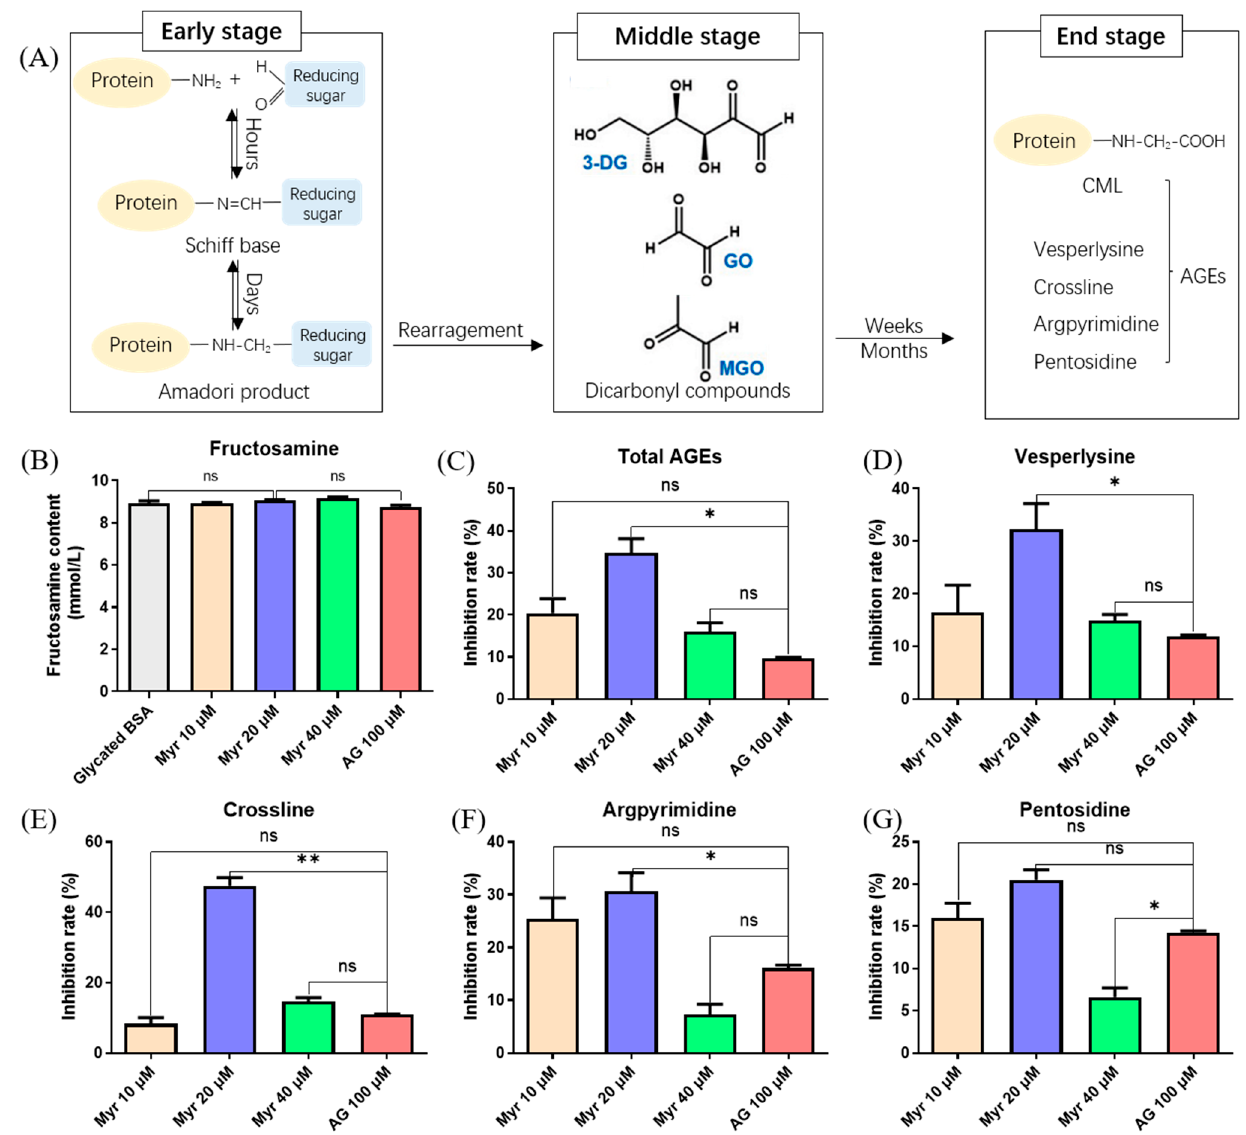
Figure 1. Effects of Myr on the glycation products formed in BSA-Glucose model at different stages. ( A ) Diagram of formation process of advanced glycation end products (AGEs). ( B ) Content of fructosamine generated at the early stage in BSA-glucose system incubated with Myriocin (Myr) or aminoguanidine (AG), measured by UV absorbance at 530 nm. ( C ) Inhibition rate of total AGEs generated at the end stage, measured by fluorescence emission at 440 nm with excitation at 350 nm. ( D – G ) Inhibition rates of different fluorescent AGEs including vesperlysine, crossline, argpyrimidine and pentosidine, measured by fluorescence at λ ex / λ em of 350/405, 380/440, 320/380 and 335/385 nm, respectively. Data were expressed as mean ± SD (n = 3). ns > 0.05, * p < 0.05 and ** p < 0.01 compared with AG.